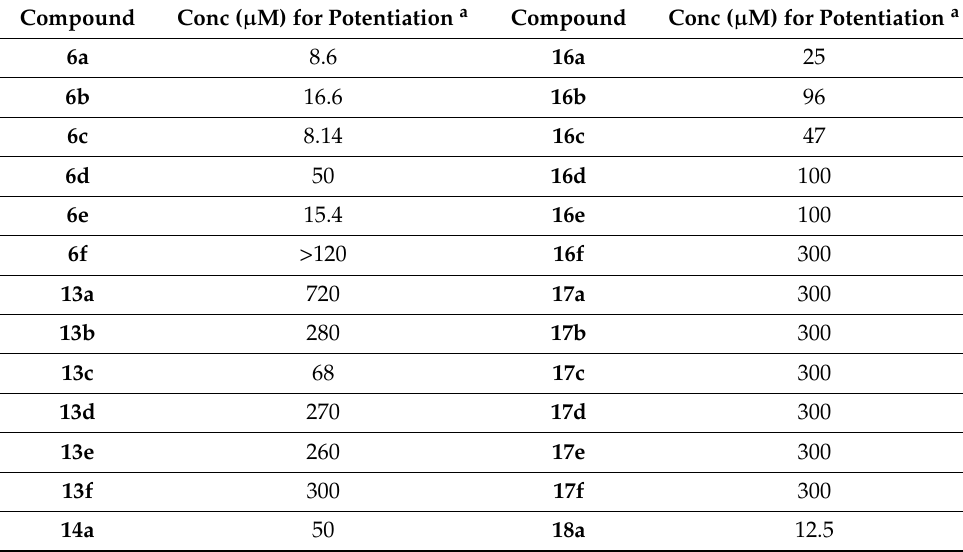
Table 3. Doxycycline potentiation activity of analogues 6, 13 – 18 .